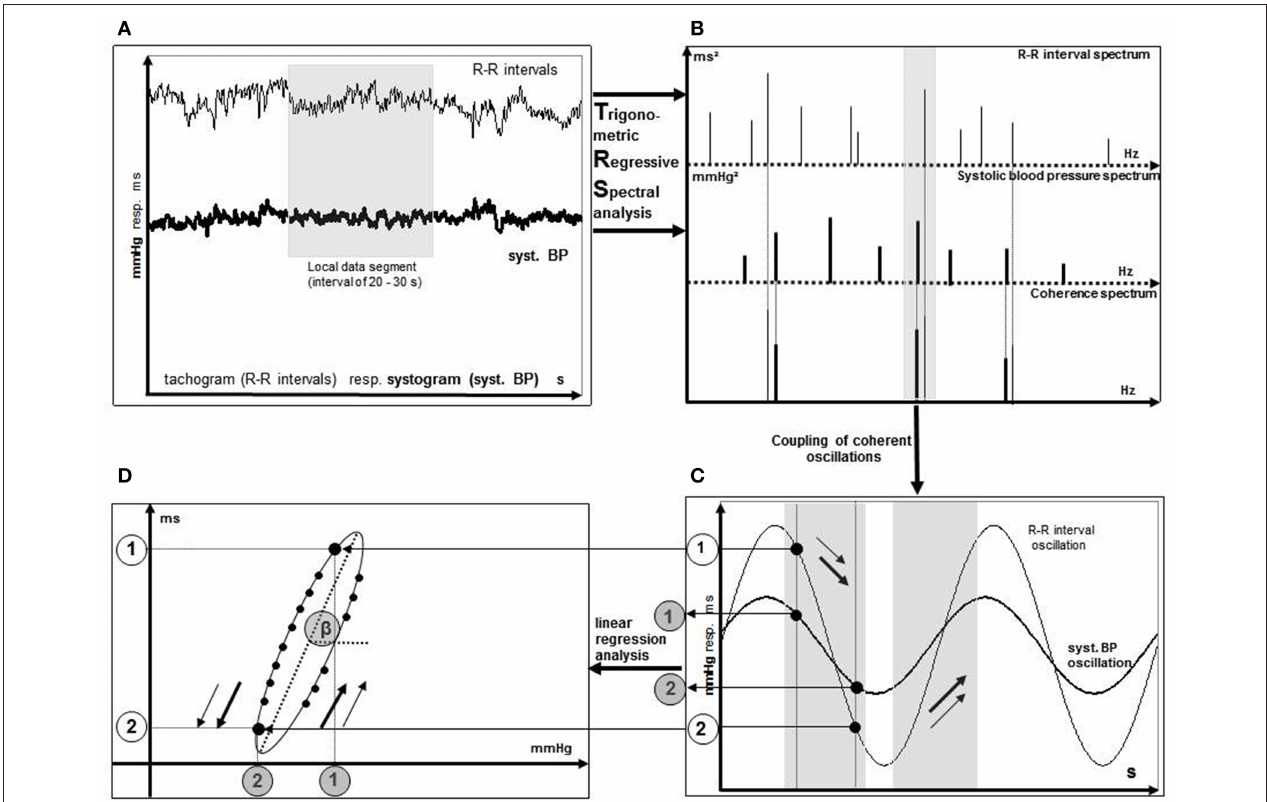
FIGURE 1 | Illustration of the BRS calculation process using TRS. Spontaneous oscillations of RR intervals and systolic blood pressure (A) are replaced by theoretical TRS oscillations (B) . Calculation of BRS as the slope of the regression line (D) originates from coherent oscillation pairs of RR interval and systolic blood pressure (C) . Points 1 and 2 are two examples of coherent oscillation pairs of RR intervals and systolic blood pressures. [Taken from Gasch et al. (2011)].